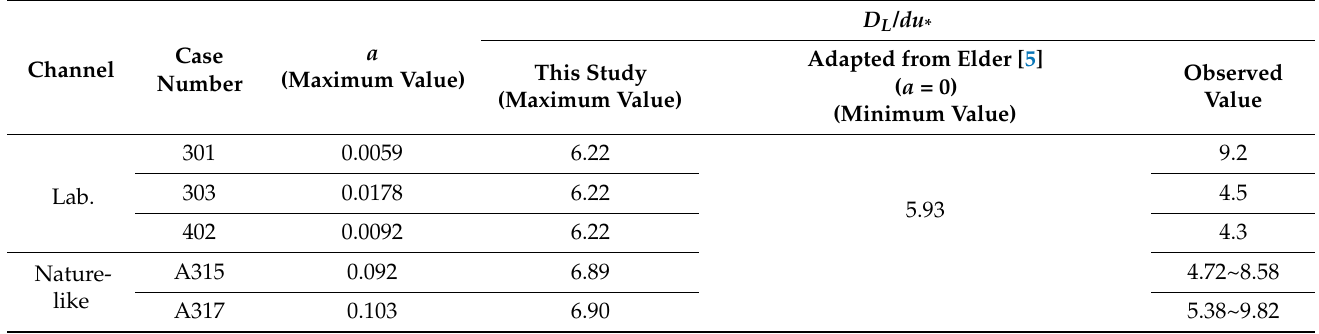
Table 1. Comparison between observed dispersion coefficients and estimated ones for laboratory and nature-like